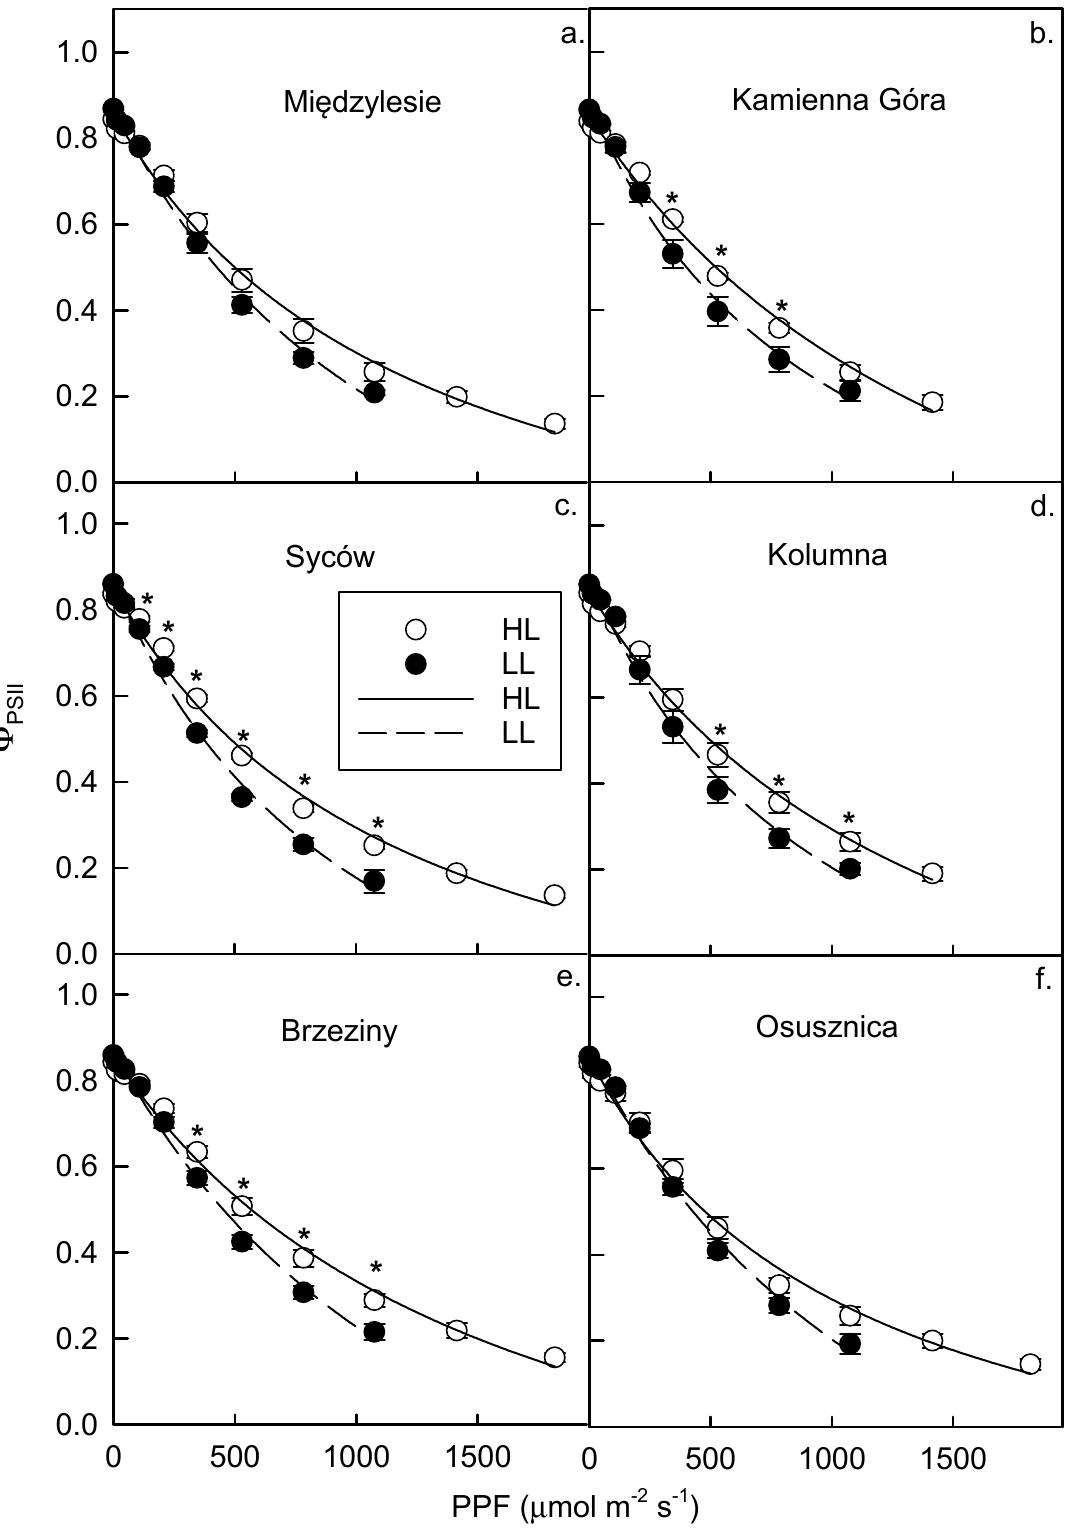
Figure 5. Light curves of PSII quantum yield photochemistry ( Φ PSII ) in needles of Abies alba seedlings originating from different provenances and acclimated to full irradiance or shade. Mean values ( ± SE) of Φ PSII are shown separately for each provenance in plots ( a – f ) in shade and in full irradiance. An asterisk indicates that mean values of Φ PSII at the given actinic PPF value are significantly different using Student’s t- test at p < 0.05 ( n = 5). PPF − photosynthetic photon flux.